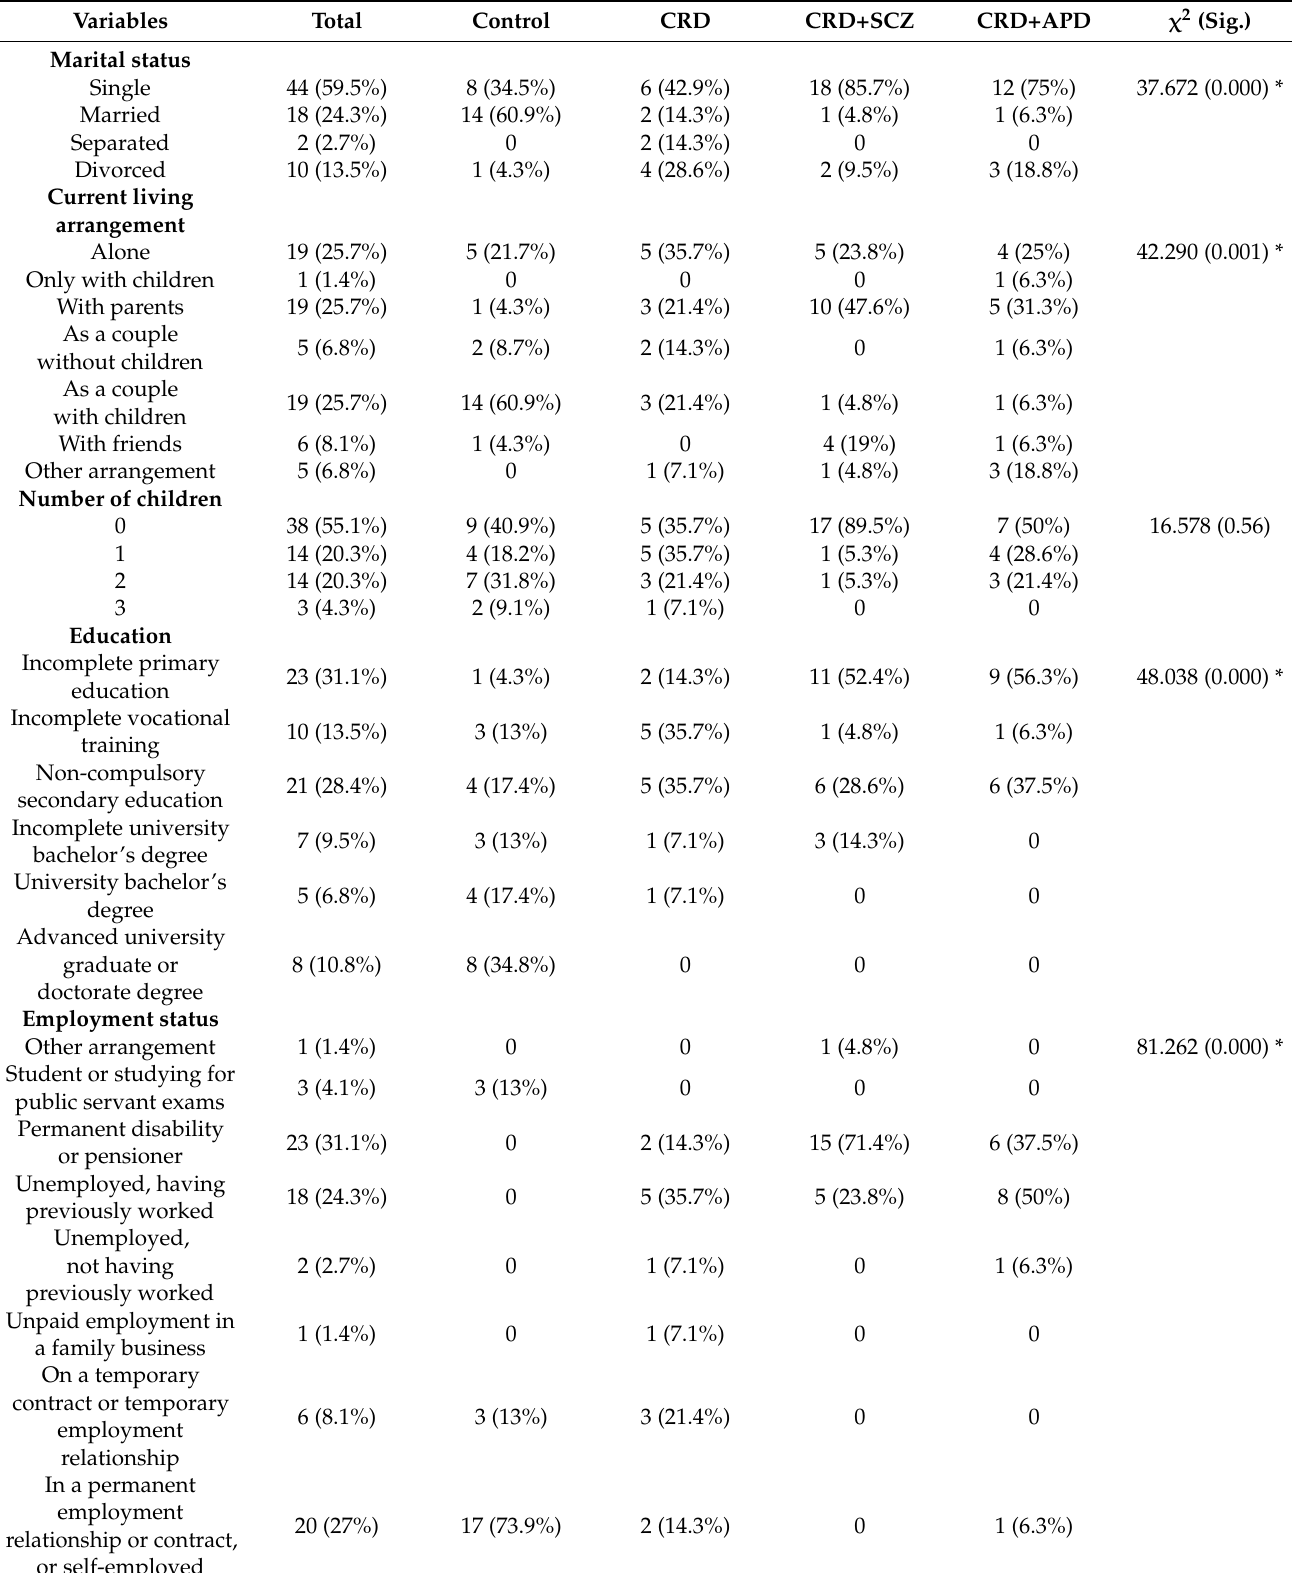
Table 1. Sociodemographic